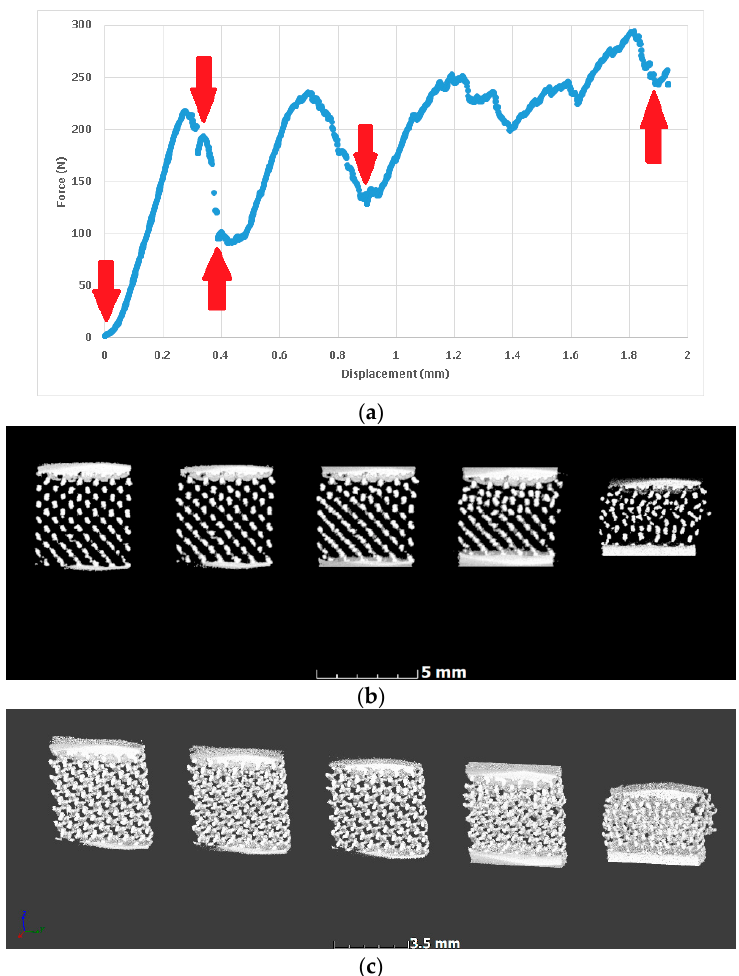
Figure 6 . In situ deformation imaging of a lattice (0.8 mm unit cell) at the selected points during yielding; steps are shown as arrows in the force-displacement curve. ( a ) Force-displacement with red arrows indicating steps for microCT scans (stop); ( b ) MicroCT slice images at each step showing collapse; ( c ) The corresponding microCT 3-D images of the lattice at each step (cropped).